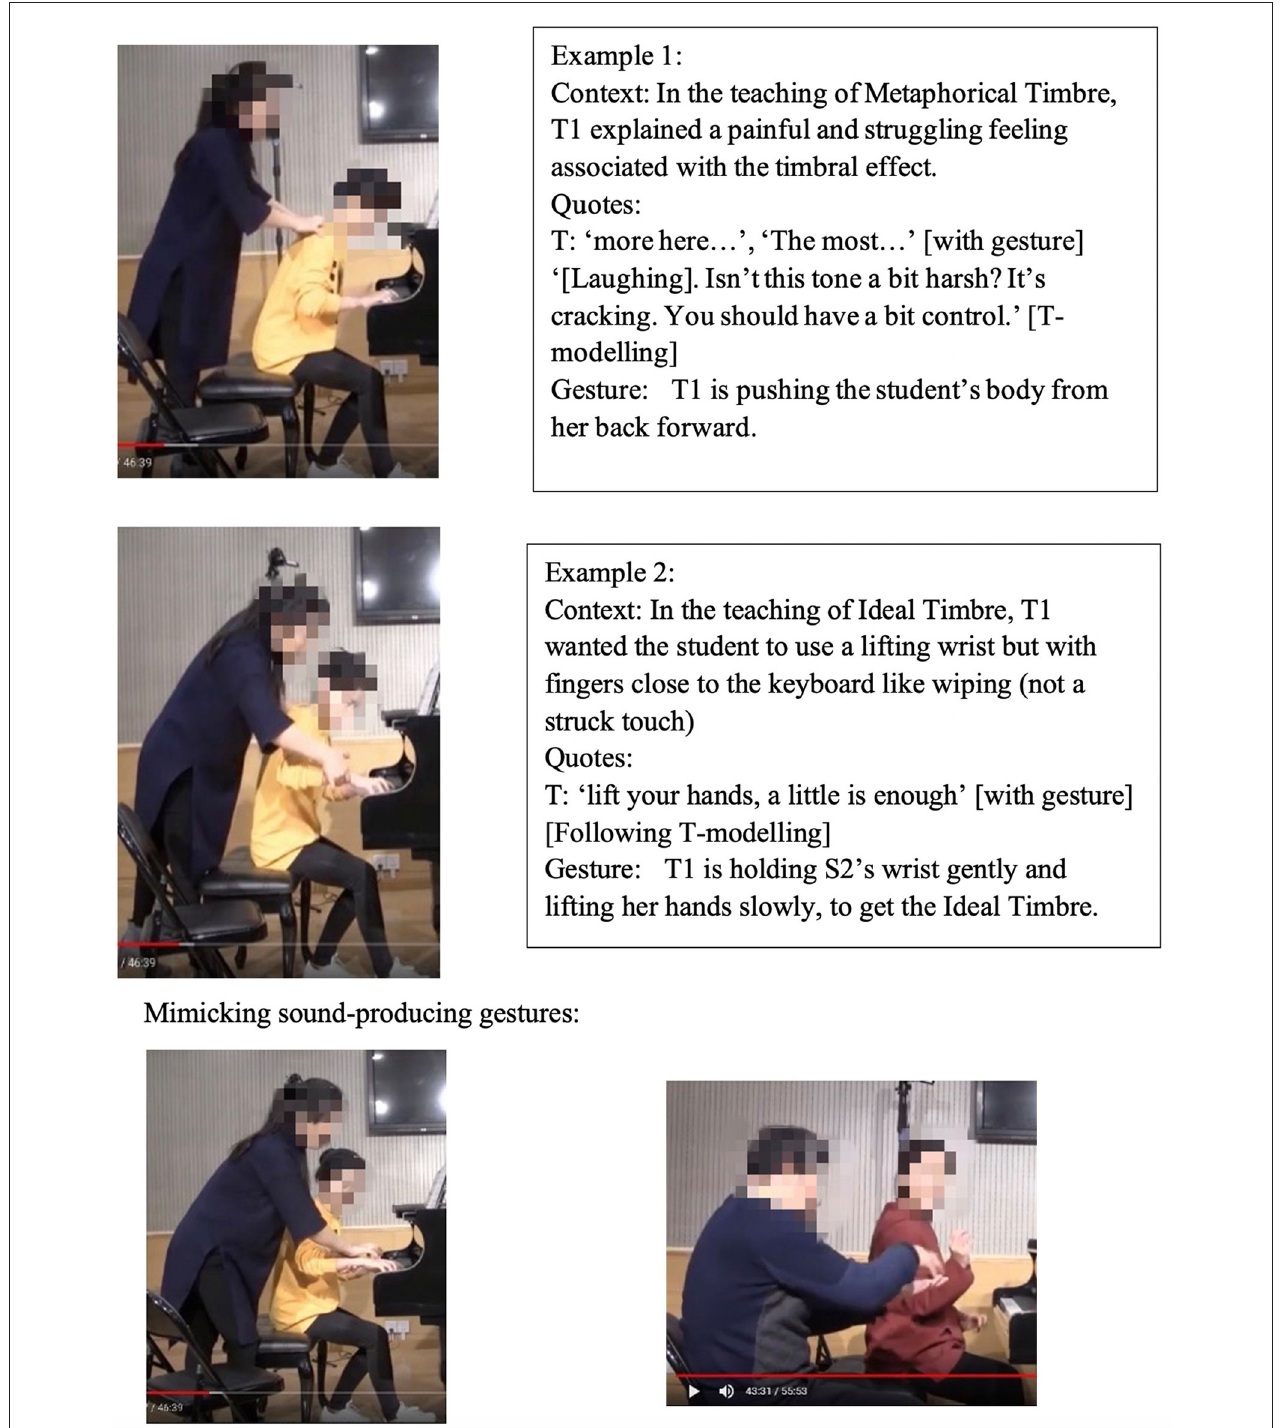
FIGURE 1 | Non-verbal behaviors in the observation study related to metaphorical timbre, ideal timbre, and illustrating sound-producing gestures. an explicit explanation of what is referred to as “more,” but she clarified her meaning by pushing the student from the back, which also changed the performance